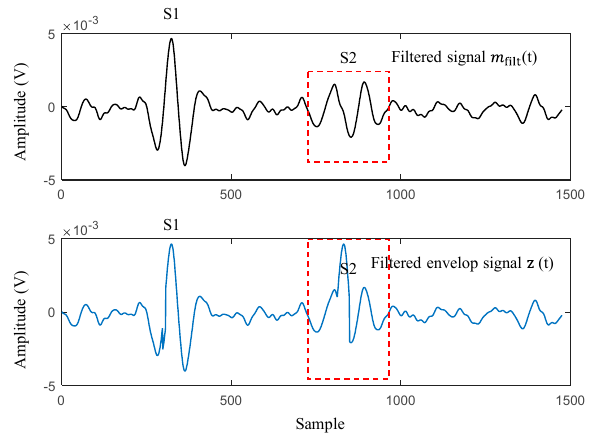
Figure 6. Example of comparison of the filtered signal m filt ( t ) and the filtered envelope signal z ( t ) .